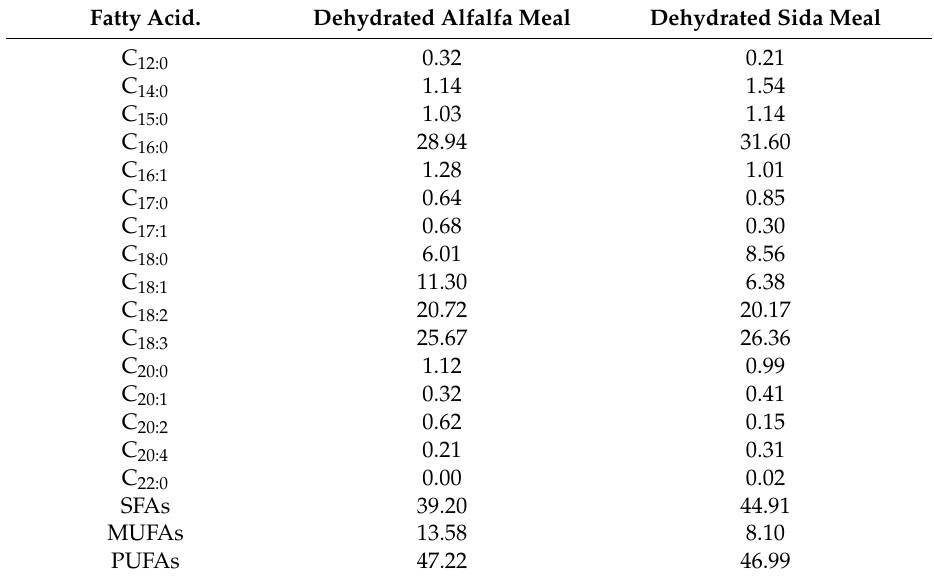
Table 3. Fatty acid profiles of dehydrated alfalfa meal and dehydrated Sida meal (% total fatty acid pool). Fatty